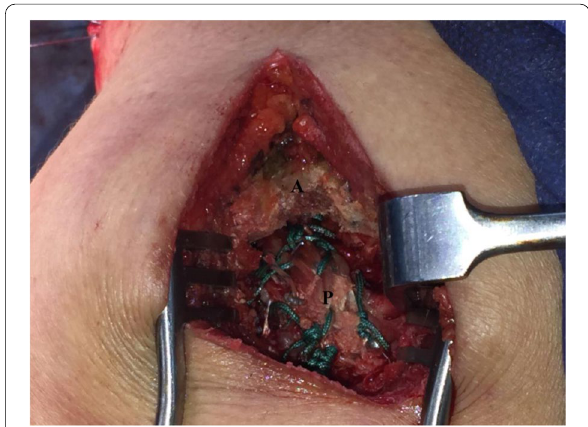
Fig. 10 demonstrates sutured periosteal end of the hamstring sheet to anatomic footprint of the rotator cuff, and additionally to the repaired rotator cuff via McKenzie approach in currently reported technique of middle trapezius tendon transfer in the right shoulder; A, acromion; P, periosteal end of the hamstring sheet